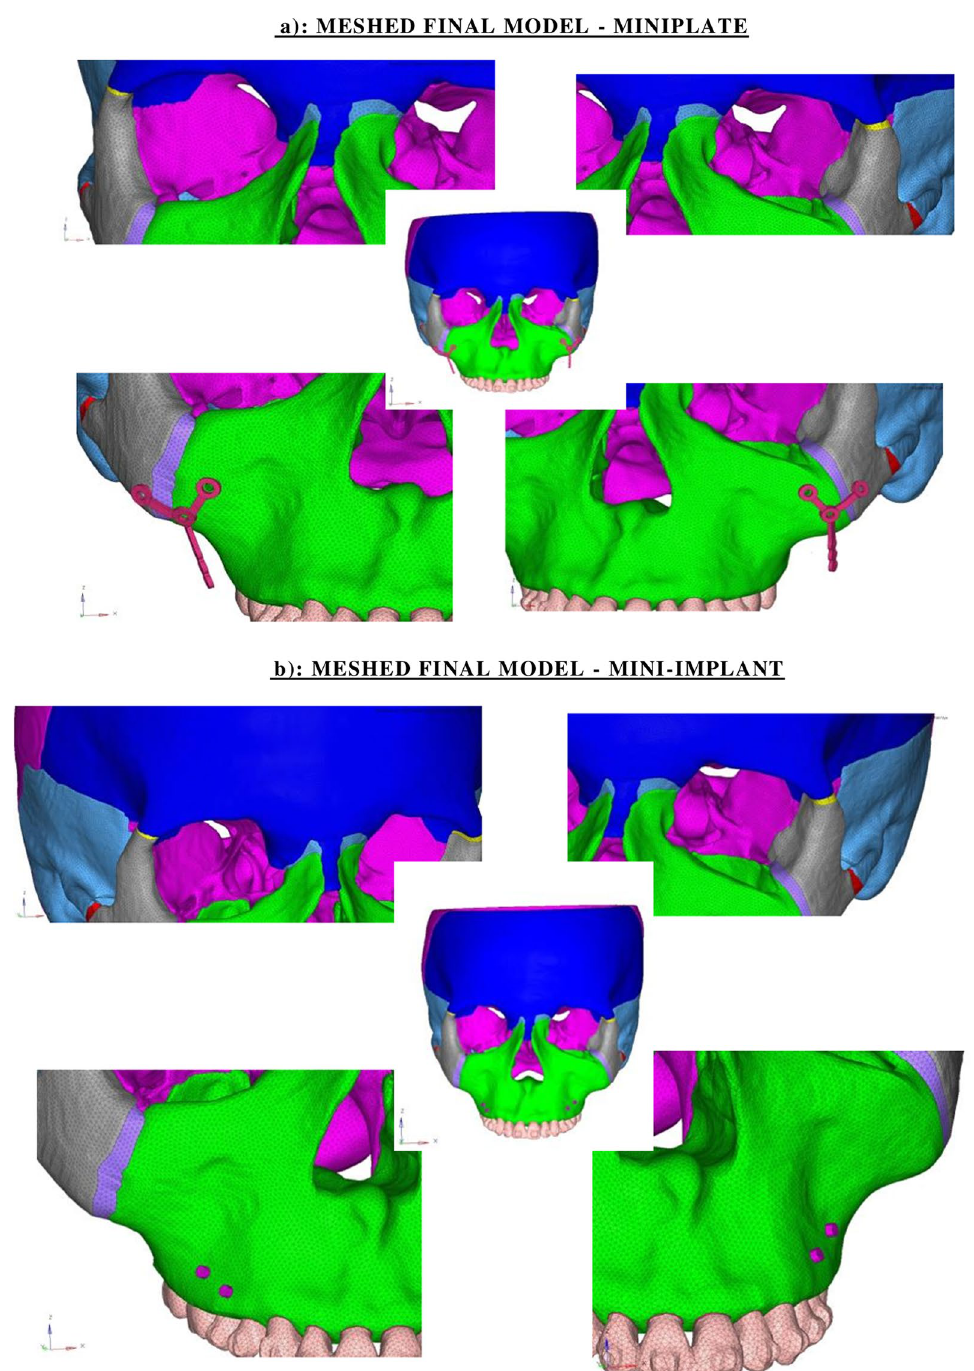
Fig. 2 a Meshed final model—miniplate. b Meshed final